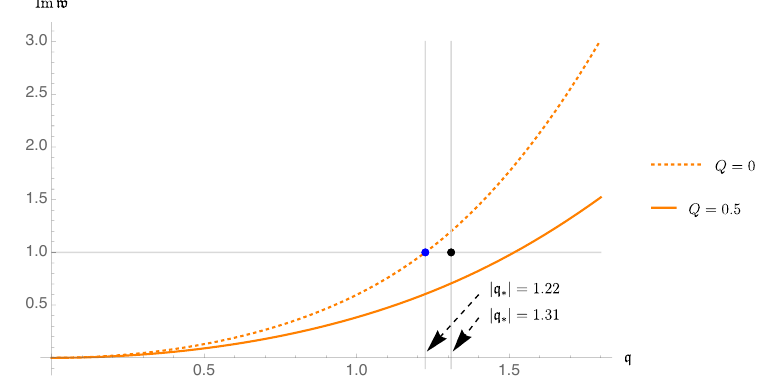
Figure 16. In a neutral (cid:13)uid, Q = 0, hydrodynamic branch of poles in spin 1 channel has a pole-skipping point denoted by blue dot. This point turns out to be ( (cid:0) w (cid:3) ; (cid:7) i q (cid:3) ) and so includes the same information about the chaos point ( w (cid:3) ; q (cid:3) ). However, when Q 6 = 0, it will no longer be the case. As an example, black dot denotes the point ( (cid:0) w (cid:3) ; (cid:7) i q (cid:3) ) evaluated at Q = 0 : 5; it obviously does not lie on the line of poles associated with Q = 0 :